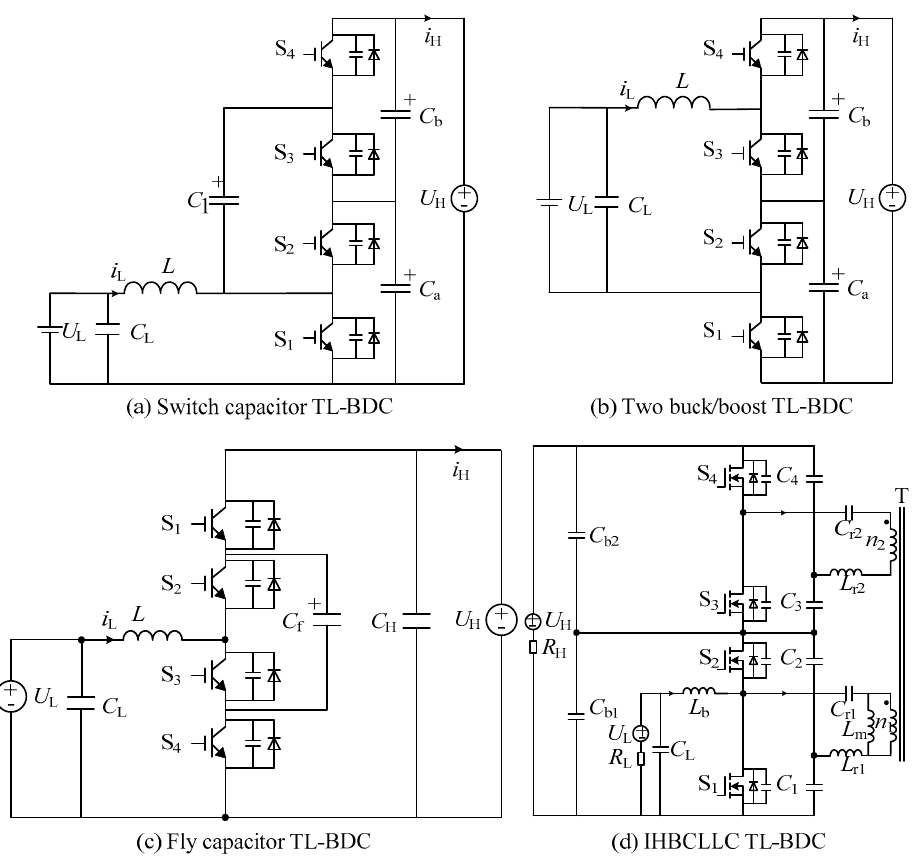
Figure 4. Non-isolated TL-BDC. IHBCLLC, integrated half bridge capacitor inductance series resonance.